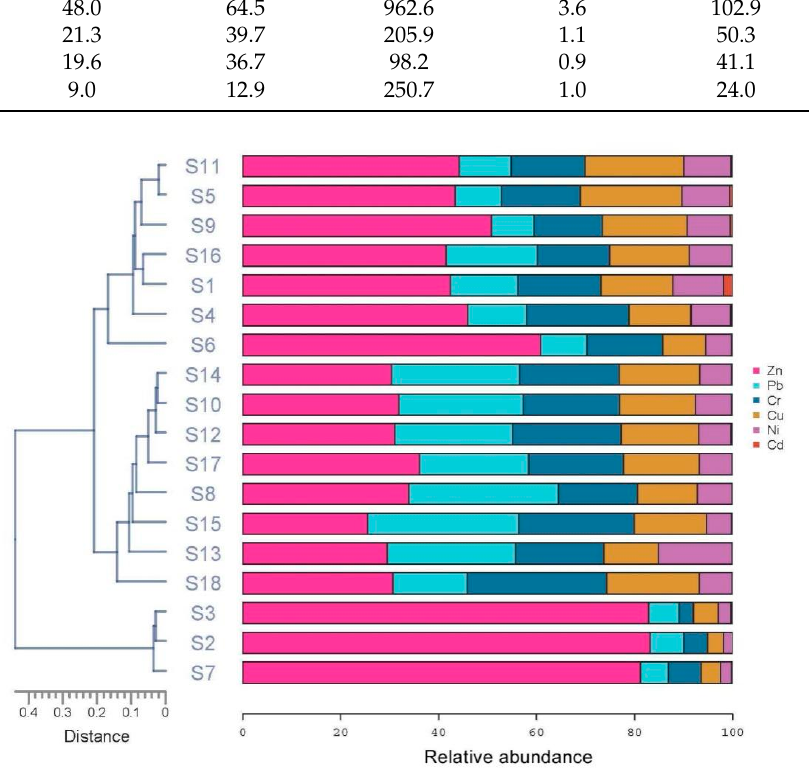
Figure 2. Composition profiles and cluster analyses of heavy metals in sediments of different sampling stations in Shantou Bay.